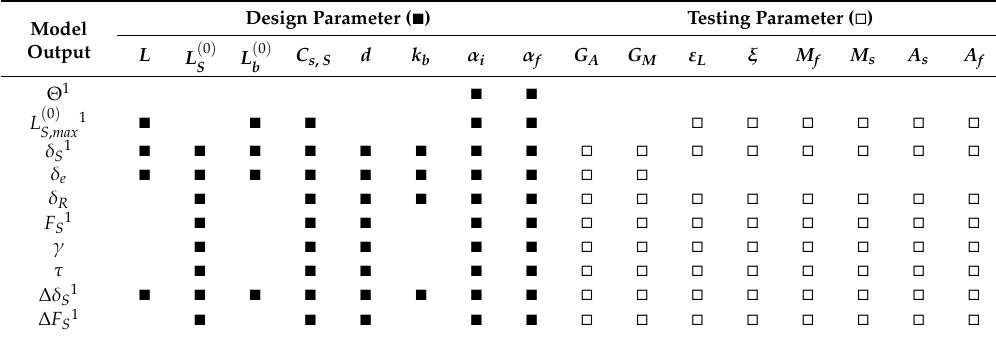
Table 1. Experimental parameter categorization.